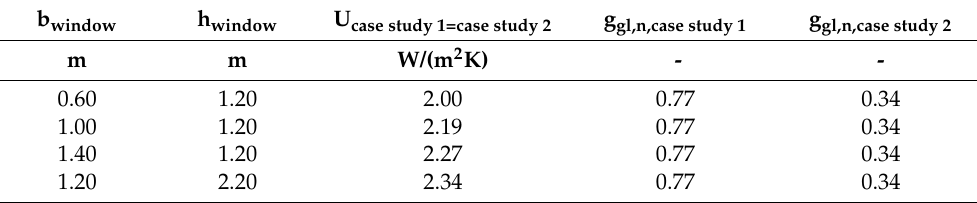
Table 5. Thermal transmittance and solar transmission coefficient of windows used.